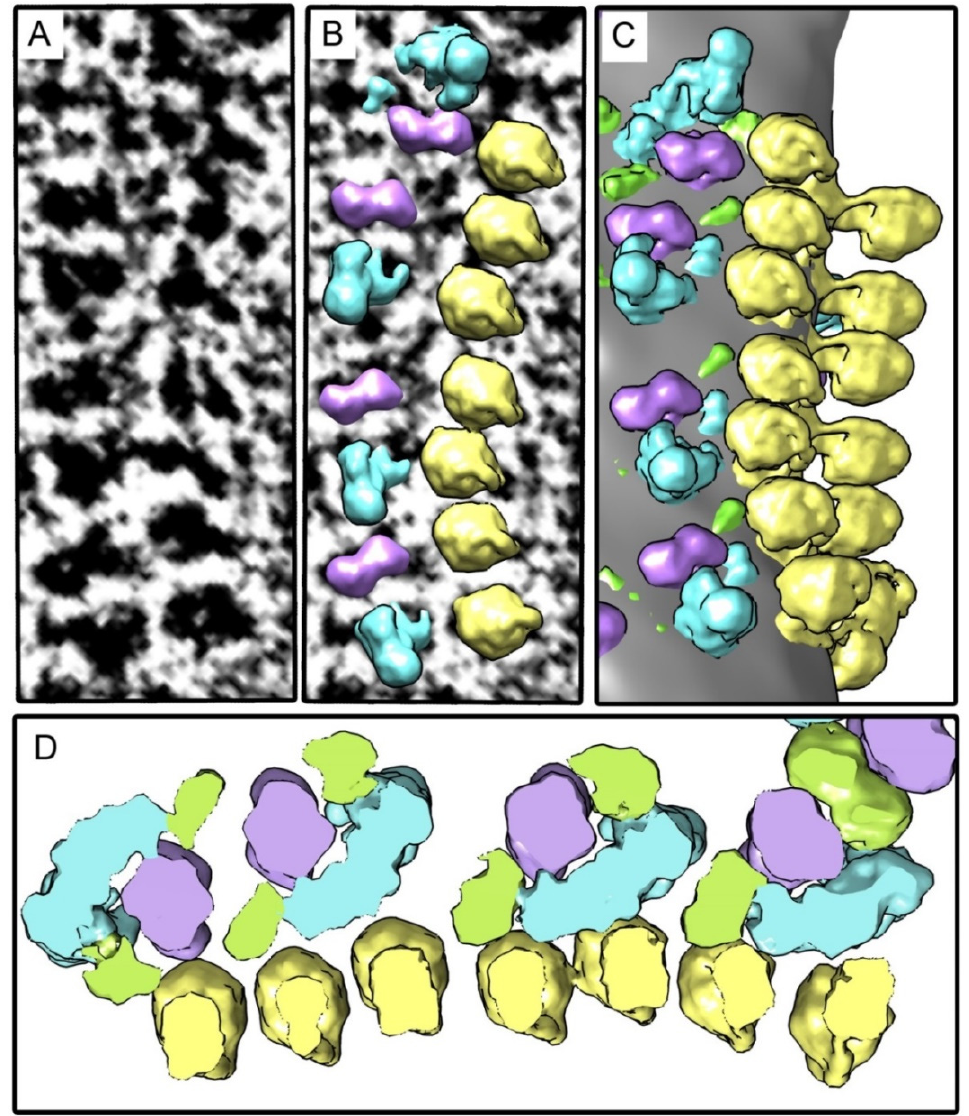
Figure 2. An example of the oligomeric linear structure consisting of tightly docked ATP synthases and respirasomes. Elongated transmembrane parts of complexes I are oriented approximately parallel to the row of ATP synthases. ( A ) Tomographic slice; ( B ) Density maps of complexes I, III 2 , and ATP synthases placed back to the tomogram; ( C ) Surface rendering of the selected area; ( D ) Slice of the density map, view from the intermembrane space. Image ( D ) is a bit enlarged in comparison with images ( A – C ). Colors: yellow–ATP synthase, blue–complex I, purple–complex III dimer, green–complex IV.